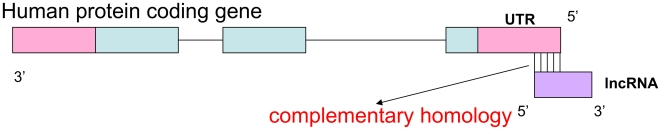
A model for antisense regulation of target mRNA transcripts by lncRNAs.The following lncRNA sequences: HIT000079026.8 and HIT000091723.8, have complementary relationship to UTR of the following protein-coding transcripts: ENST00000393449 and ENST00000383790, respectively.